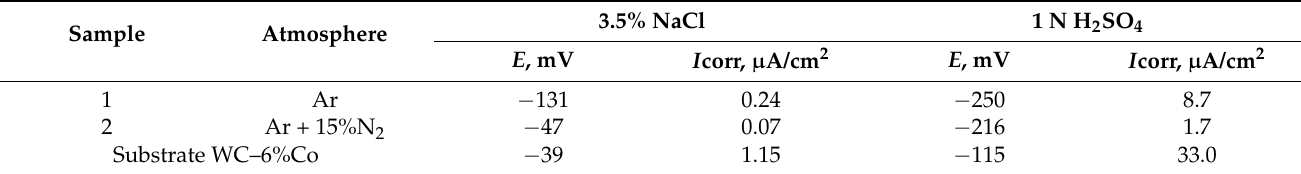
Figure 9. Results of electrochemical testing in 3.5% NaCl ( a ) and 1 N H 2 SO 4 ( b ) solutions. Table 2. The results of electrochemical